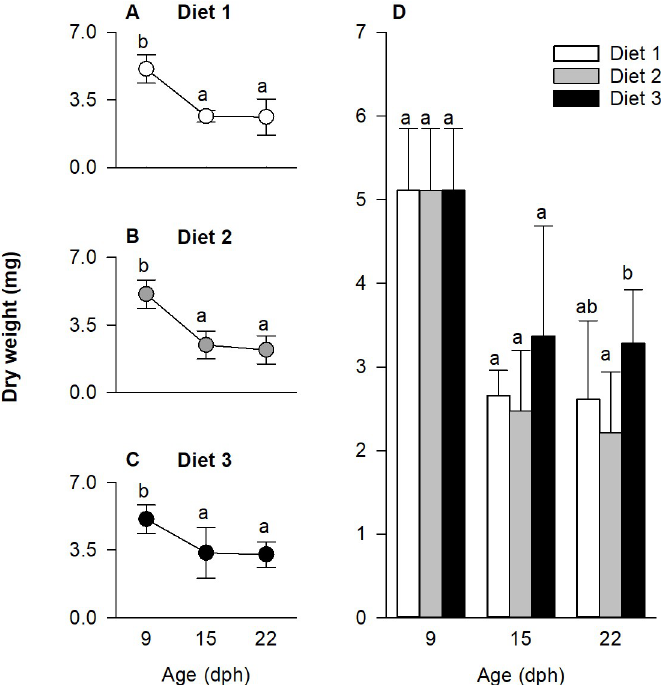
Fig 4. European eel, Anguilla anguilla , dry weight (mg/ind) during larval development. Effect of age at each diet (A-C) and effect of diets at each age (D). Values represent means ( ± SEM), while different lower-case letters represent significant differences (p <